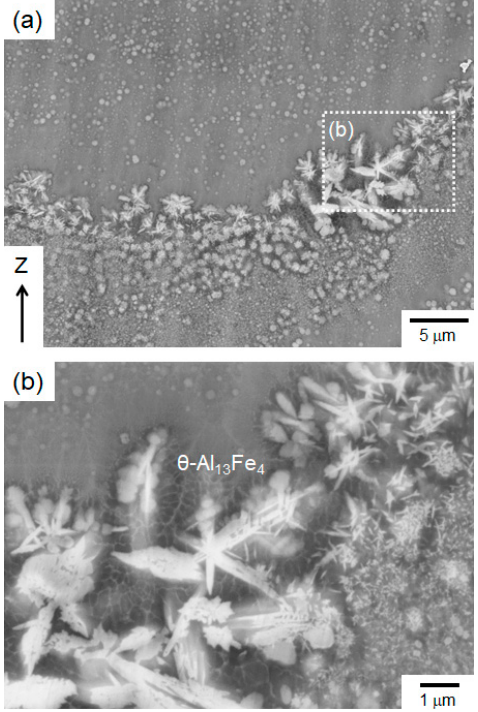
Figure 4. ( a ) Low-magnification and ( b ) high-magnification SEM images showing the microstruc- ture around melt pool boundaries in an L-PBF-built sample under 128 W–0.4 m·s –1